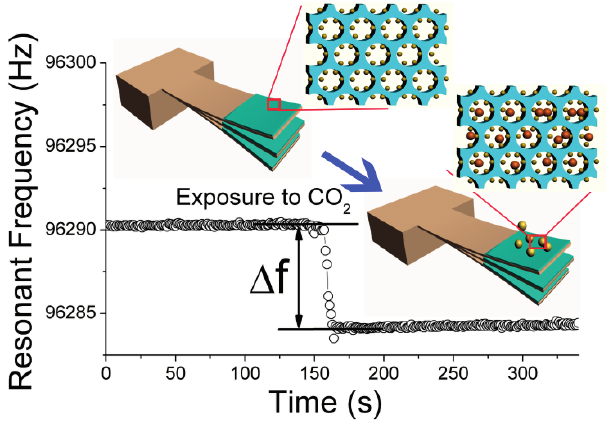
Figure 1. Schematic of micro-gravimetric sensing mechanism of resonant micro-cantilever sensor, at the end of which the nanoporous sensing material is loaded. Reprinted with permission from